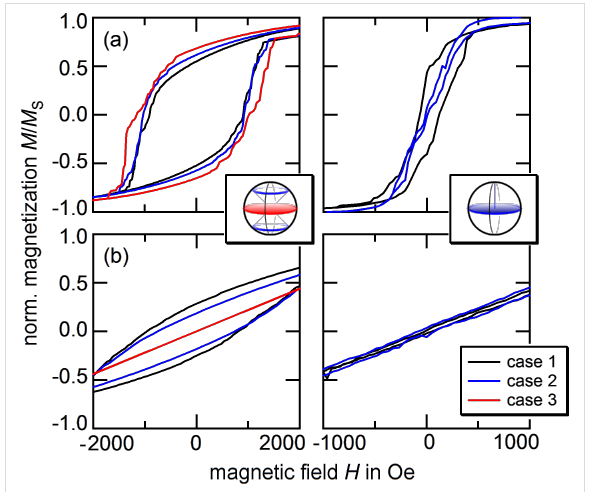
Figure 6: Hysteresis loops of the 10 × 10 hexagonal lattices shown in Figure 5 for different anisotropy cases obtained from numerical calcu- lations. (a) and (b) show the behavior of particles with a uniaxial anisotropy and K u = 10 5 J/m 3 for in-plane and out-of-plane external fields; (c) and (d) show the respective results for cubic anisotropy with K c = 3 × 10 4 J/m 3 . The insets visualize the different choices for the distribution of easy